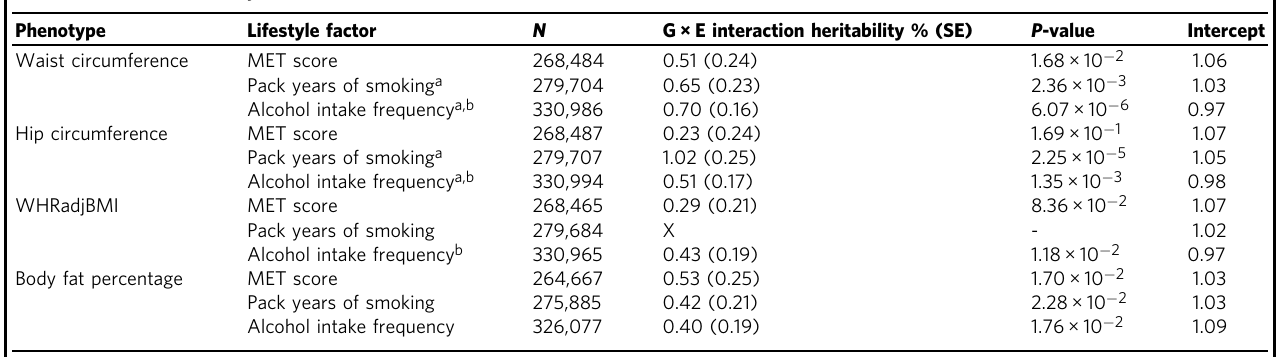
Table 4 G × E interaction heritability calculated using the LDSC method.